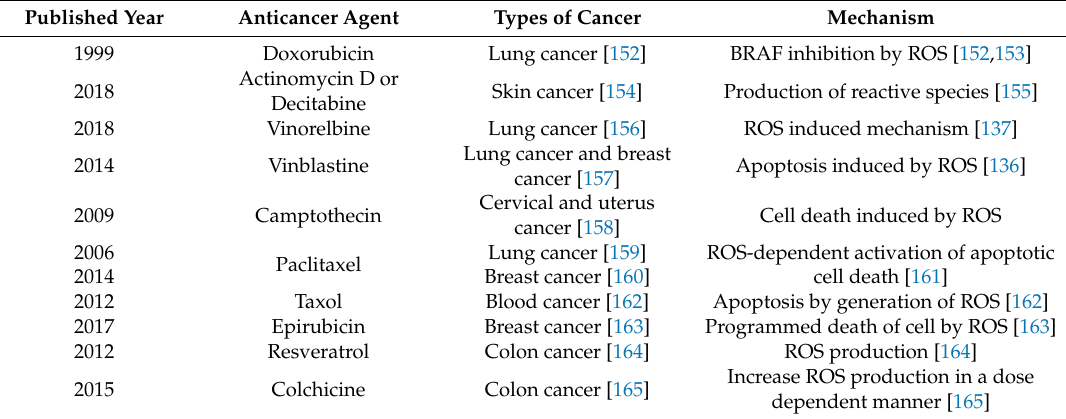
Table 1. List of anticancer agents applied to di ff erent cancer treatment and their mechanism of action by increasing ROS